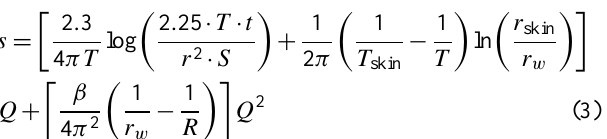
Figure 3: qualitative recharge. The colour scale reflects the different attitude to recharge of the zones, ranging from high (red) to low (blue).